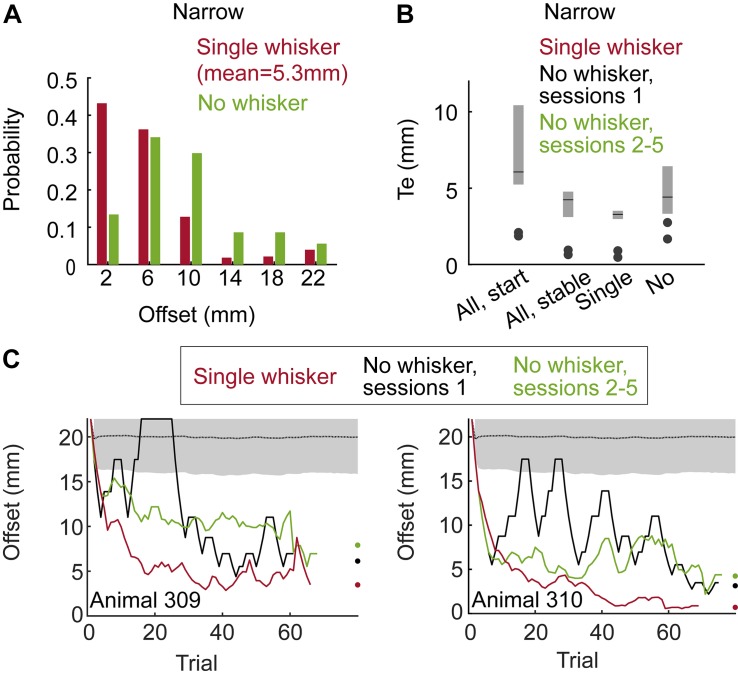
Localization by whiskers and body. (A) Distributions of localization thresholds in the single whisker (red) and no whisker (green) conditions (Group 1 - Narrow, Staircase). (B) Localization threshold (Te) for the two animals in Group 1. All-start/All-stable: sessions with all whiskers, start training (first sessions) and when behavior was stable (last sessions). Single/No – three sessions before/after trimming the last (bilateral) single whiskers. Te is defined as in Knutsen et al. (2006), see their Figure 10. Black lines indicate the median Te and the lower and upper end of the gray bars indicate the first and third quarantines, respectively. (C) Mean offset as a function of trial number for two animals. Means over the last 5 sessions with a single whisker (red), the first session after trimming (black) and the mean over sessions 2–5 after trimming (green). Black dotted line and gray shade are the mean and standard deviation for the offset of a rat performing at chance level (N = 5000 simulated sessions).